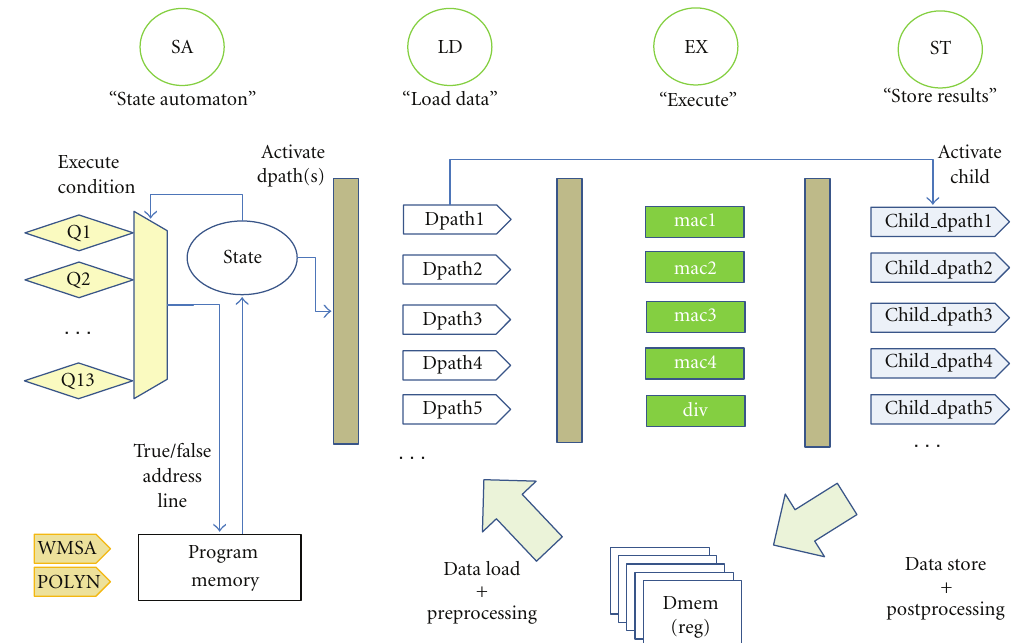
Figure 9: The architecture with just-enough flexibility to support the two channel estimation algorithms. algorithm-specific structures remain in the form of specific LD and ST operations, which translate in little area